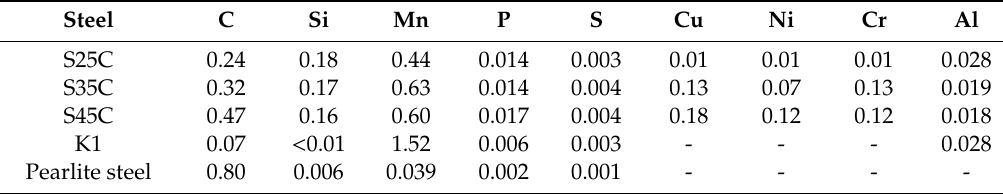
Table 1. Chemical composition of steels (in